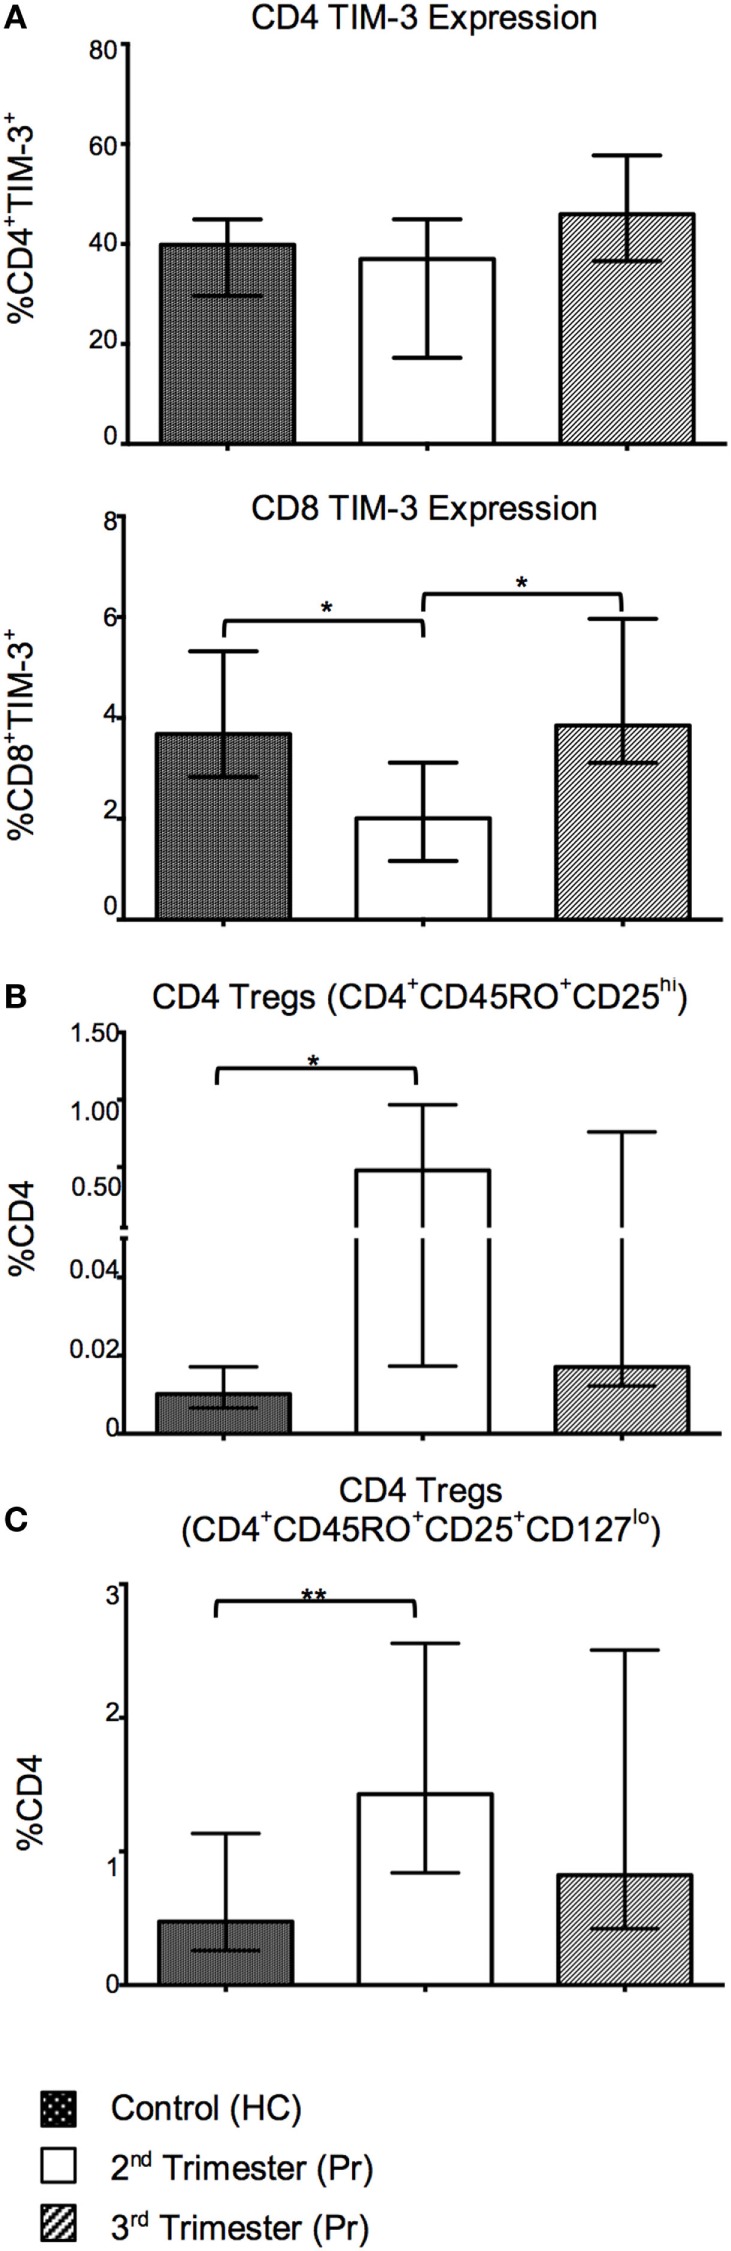
Tolerant T-cell phenotypes are favored in pregnancy and reflect changes in T-cell activation with increasing gestation. (A) Percentage expression of CTLA-4 on TIM-3 negative and positive, CD4 and CD8 T cells in pregnancy compared with controls. (B,C) Proportions of CD4 regulatory T cells (Tregs) in pregnancy. These cells were identified using the phenotype CD4+CD45RO+CD25hi and CD4+CD45RO+CD25+CD127lo. *p < 0.05 and **p < 0.01. Columns indicate median and error bars interquartile range. *p < 0.05 and **p < 0.01 (Mann–Whitney U). Abbreviation: HC, health control; Pr, pregnant.